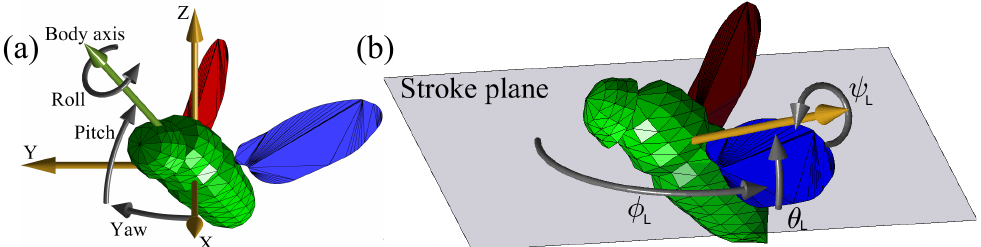
Figure 1. Basic 12-DOF model parameters. ( a ) Body 6 DOF describing its position and orientation. ( b ) Each wing is described by 3 Euler angles relative to the stroke plane: stroke ( φ ), elevation ( θ ) and wing pitch ( ψ ). The annotations are for the left